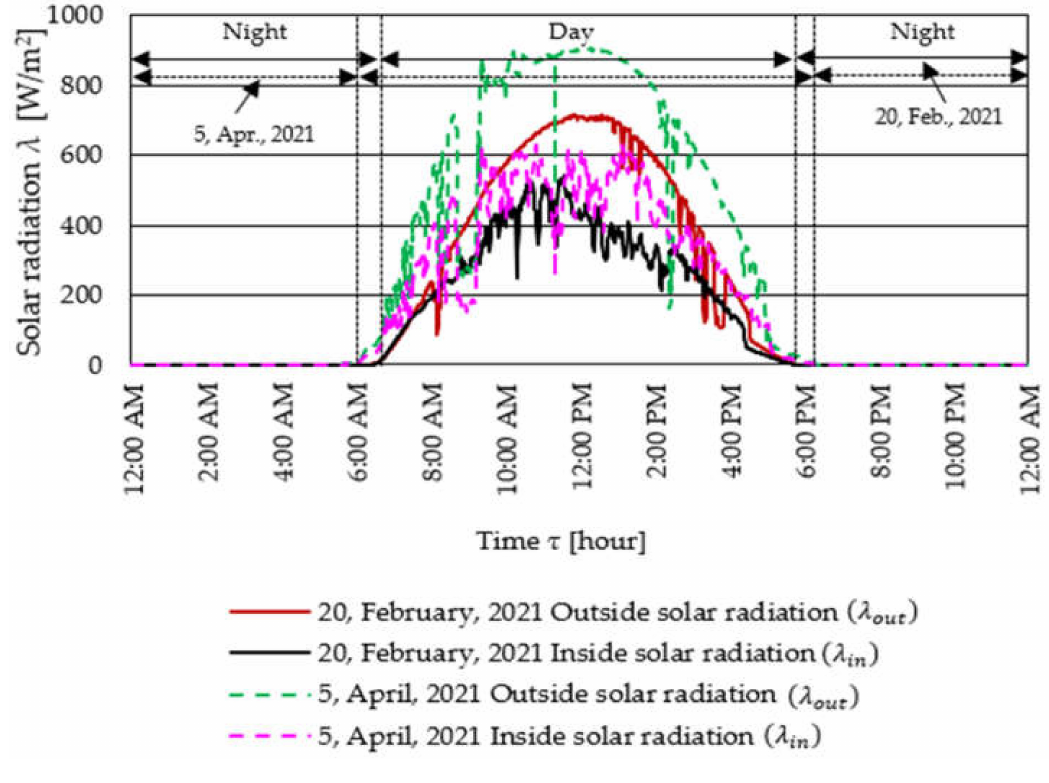
Figure 10. Variation in solar radiation inside and outside the greenhouse on each